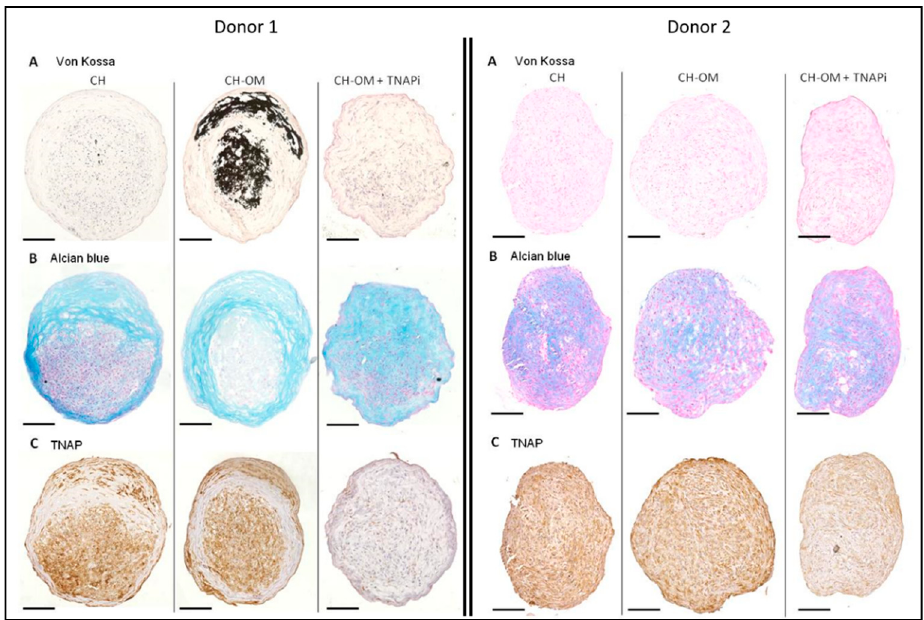
Figure 5. Mineralization ability of TLC in 3D pellets and effects of a TNAP inhibitor ( N = 3). ( A ) Representative images of Von Kossa staining of TLC pellets for two patients: mineralization was observed with donor 1, contrary to donors 2 and 3. ( B ) Alcian blue staining. ( C ) TNAP staining. CH = chondrogenic medium for 4 weeks; CH-OM = chondrogenic medium for 1 week followed by 3 weeks in mixed chondrogenic / osteogenic medium; TNAPi = tissue non-specific alkaline phosphatase inhibitor, added for the last three weeks. Scale bar = 100 µm.